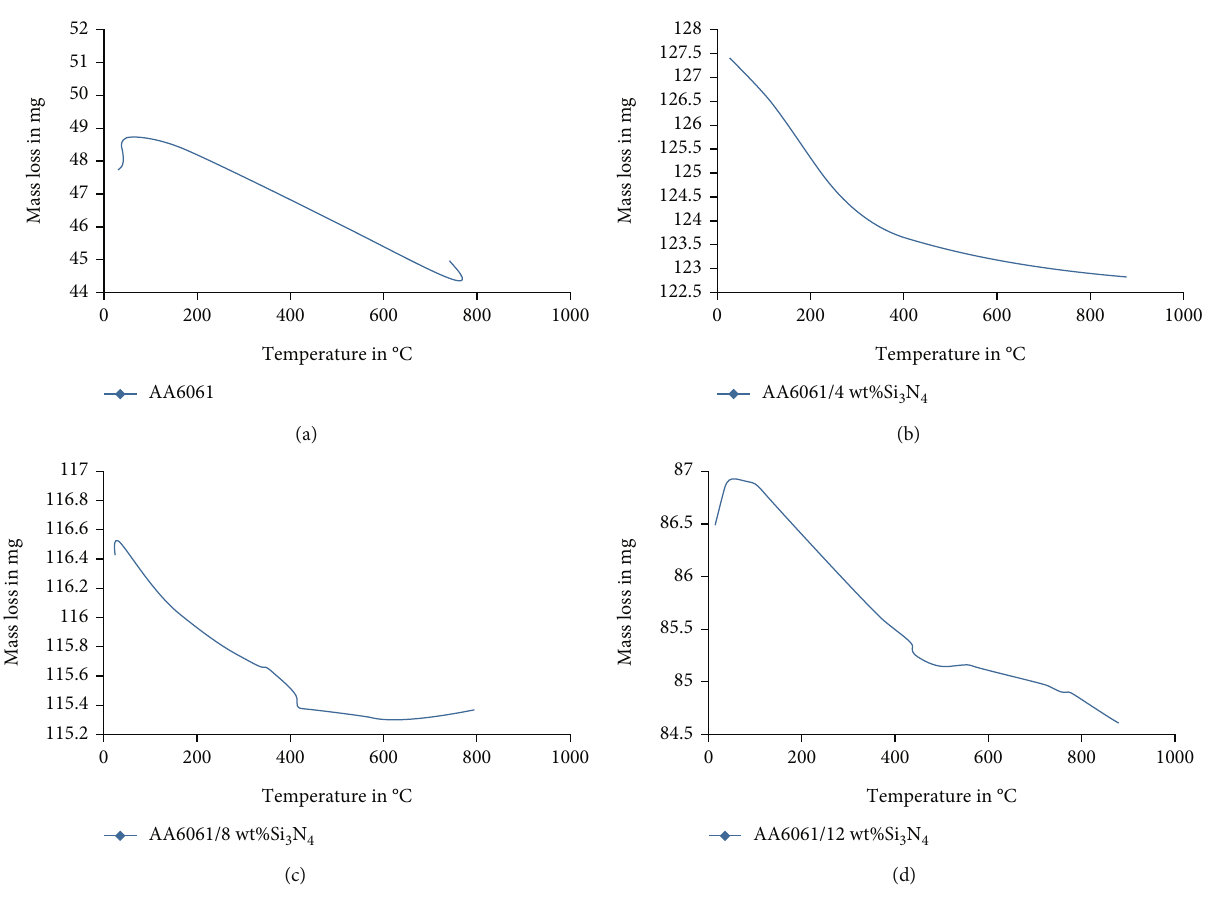
Figure 5: (a) Thermogravimetric analysis for AA6061/0 wt% Si Thermogravimetric analysis for AA6061/8wt% Si